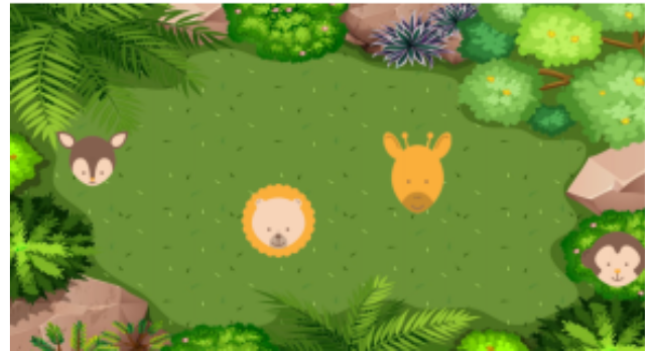
Figure 11. Interface of the game “Animal Detective”, Level